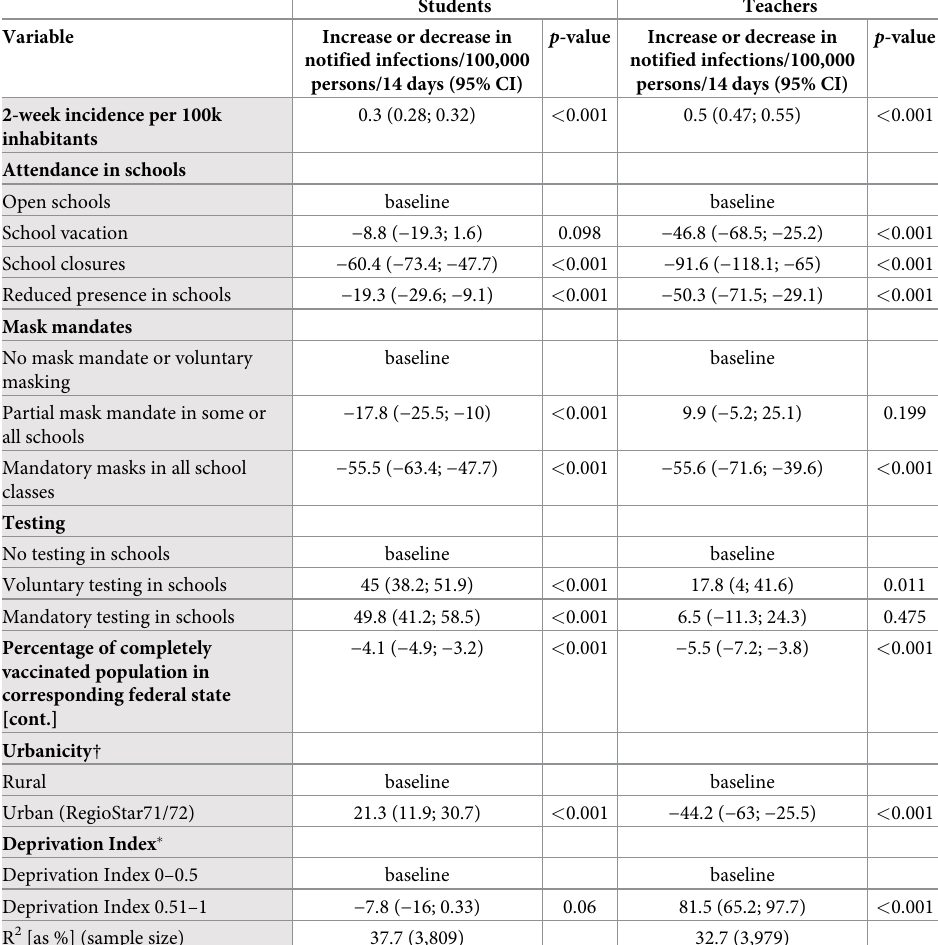
Table 5. Regression results for active cases per 100k students or teachers, respectively, on the 2-week-lags of school-specific